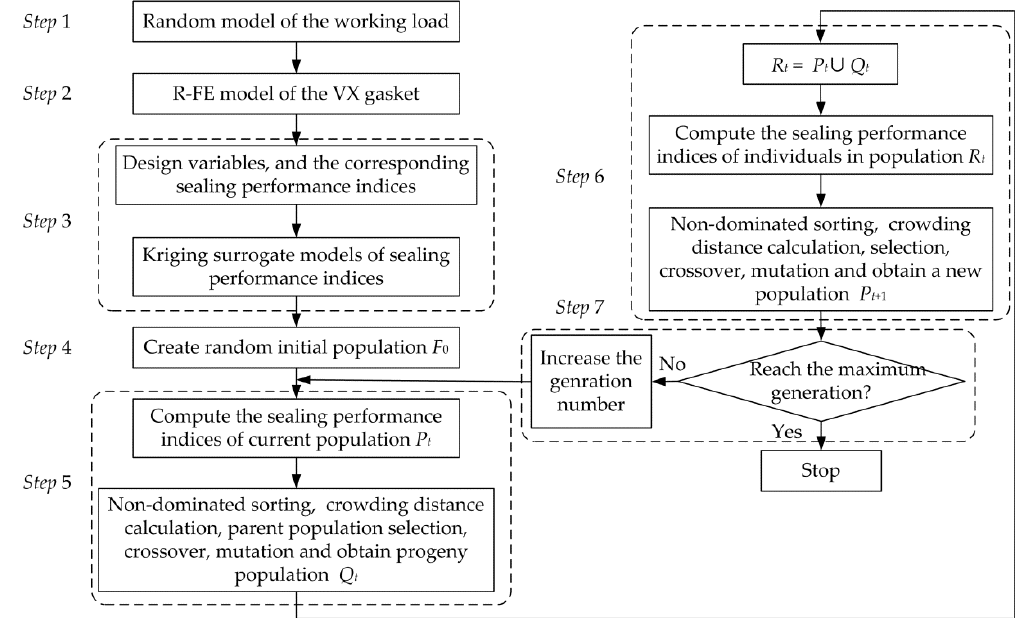
Figure 3. The flowchart of the Kriging surrogate model-NSGA- Ⅱ algorithm. R-FE, random finite element.